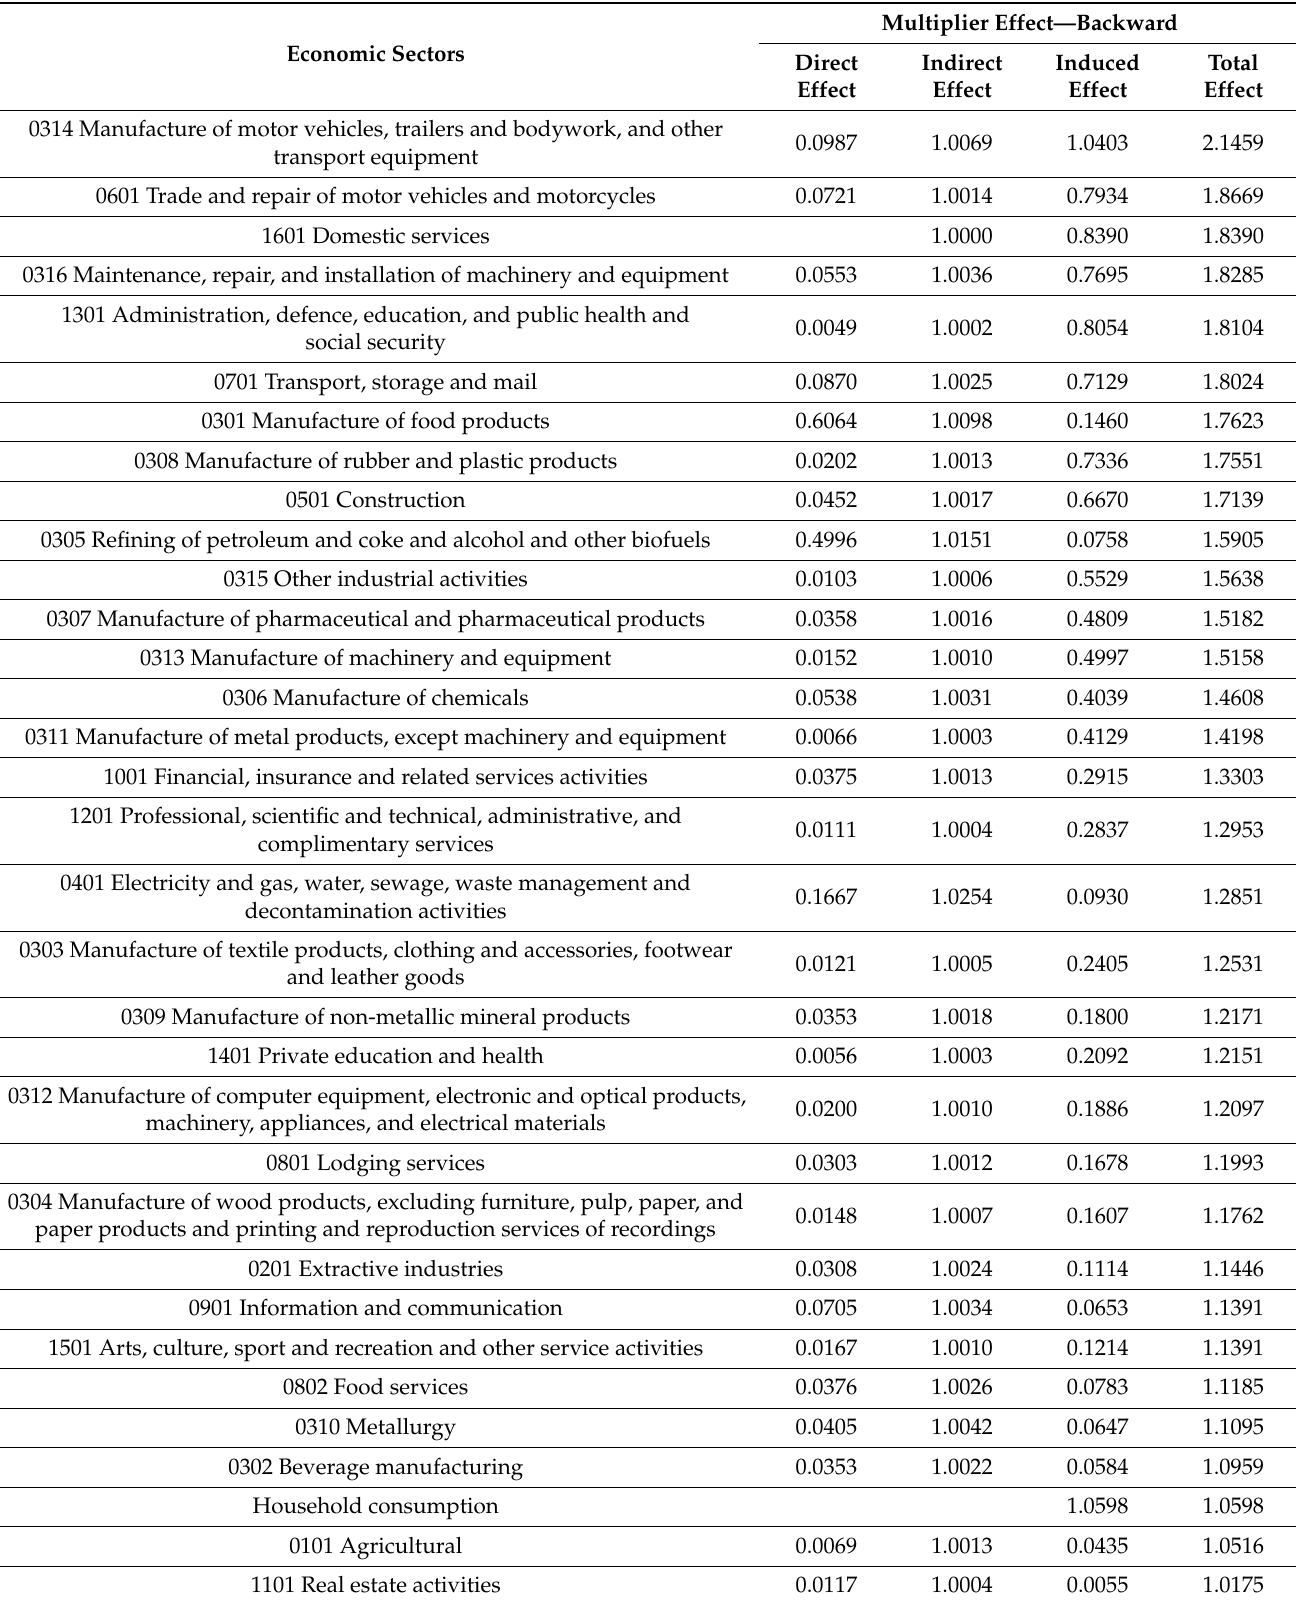
Table A3. Economic sectors with greater impact multiplier effect—Back (Direct, indirect and induced, and total effects) on water flows, Cear á